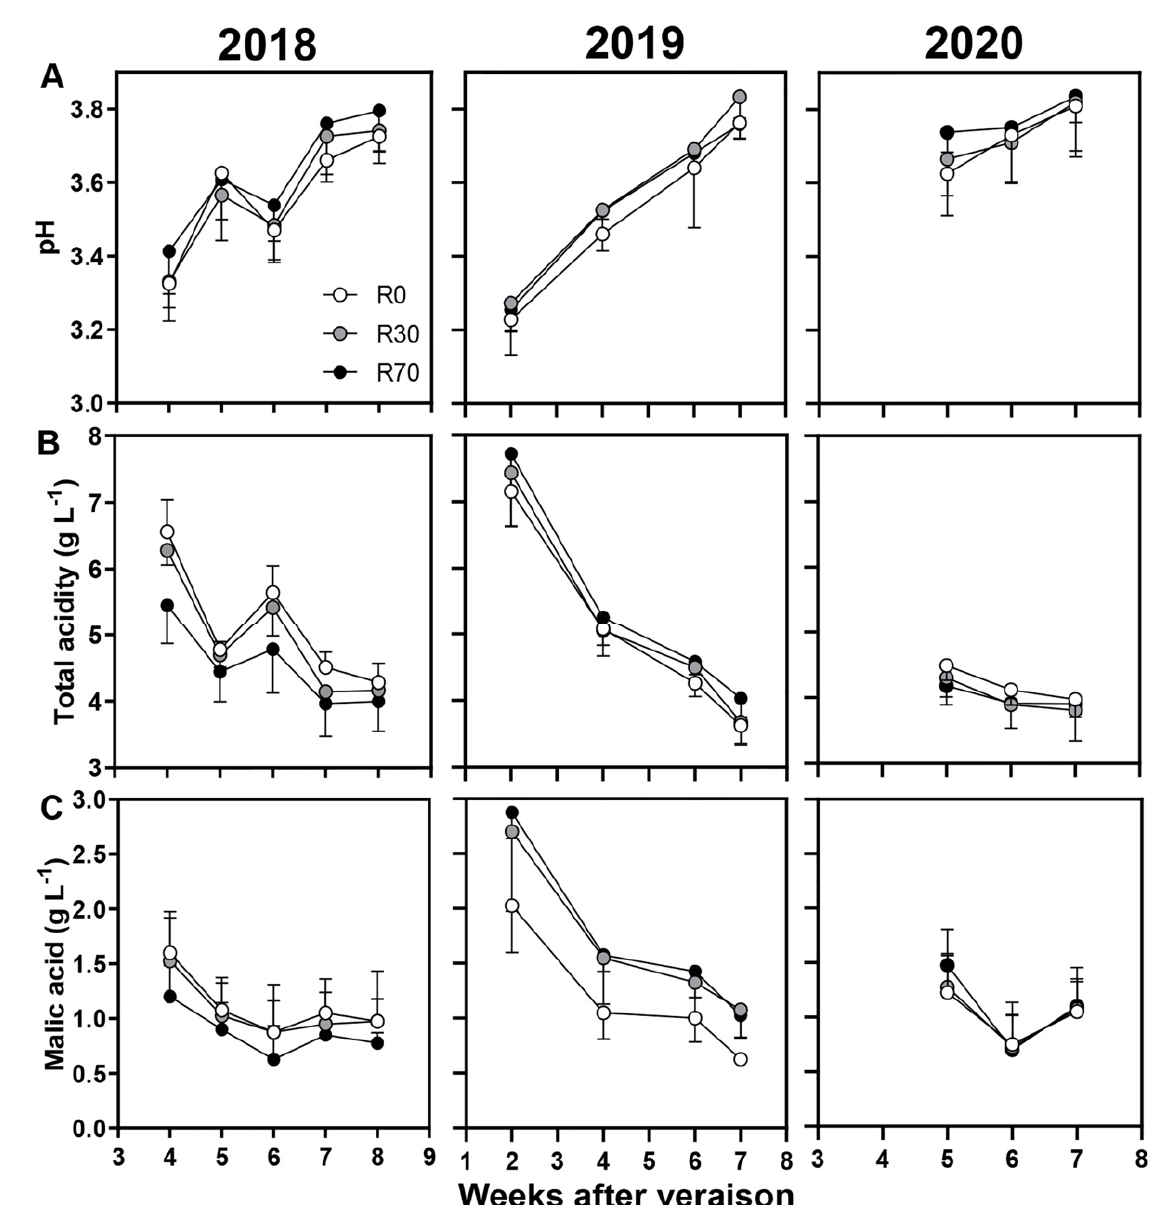
Figure 4. Berry quality attributes during maturation until harvest: ( A ) pH, ( B ) total acidity, and ( C ) malic acid in 2018, 2019, and 2020 vintages of grape cv. ‘Touriga Nacional’ in different irrigation conditions. Irrigation conditions: R0 = non—irrigated plants; R30 = deficit irrigation corresponding to 30% of evapotranspiration; R70 = deficit irrigation corresponding to 70% of evapotranspiration. Results represent mean ± SD of four replicates.